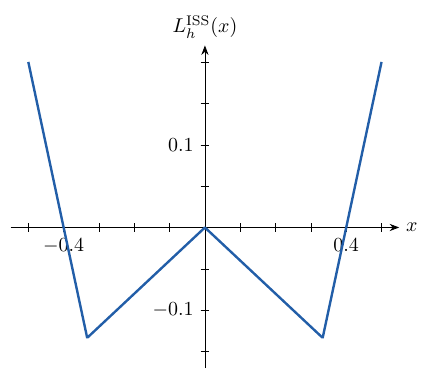
Figure 1 . The Rains function of the SU(2) ISS model. Its minima lie at x = (cid:6) 1 =